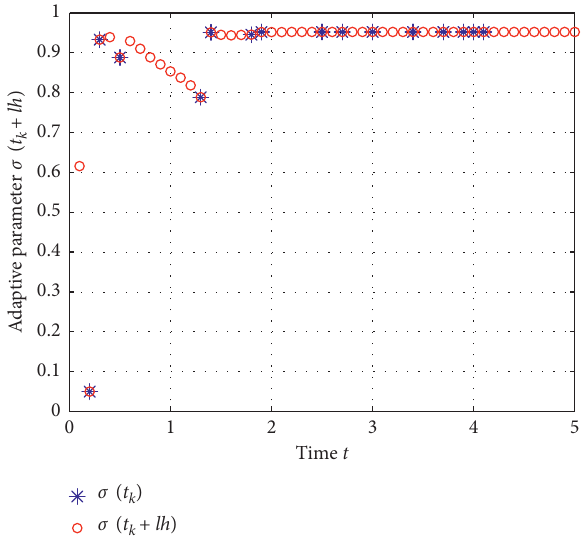
Figure 10: Adaptive parameters for Example